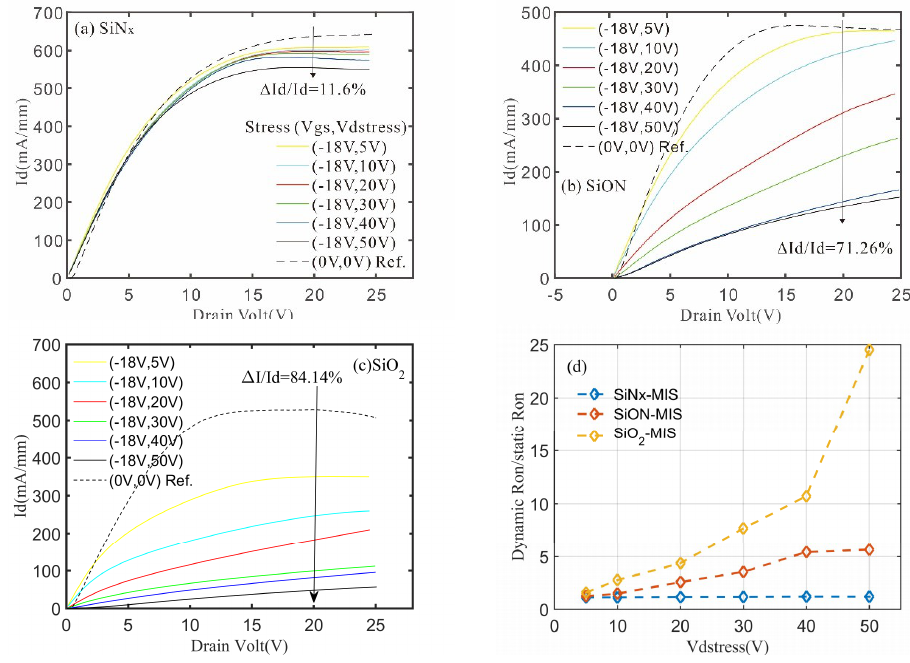
Figure 6. Id-Vds curves at V gs = 0 V of ( a ) SiN x MIS-HEMT ( b ) SiON MIS-HEMT ( c ) SiO 2 MIS-HEMT after off-state stress bias at V gs = − 18 V, Vds stress at 5, 10, 20, 30, 40, and 50 V for 10 s. ( d ) The ratio of dynamic Ron and static Ron versus different off-state Vds